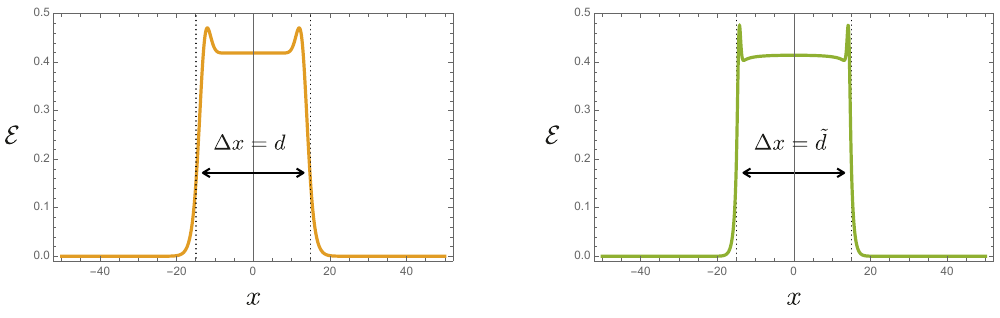
Figure 3 . The energy density pro(cid:12)les of the domain walls with d = 30 ; ~ d = 1 = 8 (left) and d = 1 = 8 ; ~ d = 30 (right). The mass and FI parameter are at the self-dual point ( m; (cid:24) ) = ( (cid:25); 1). From the connectivity of the function X , the width of the wall (cid:1) x can be estimated